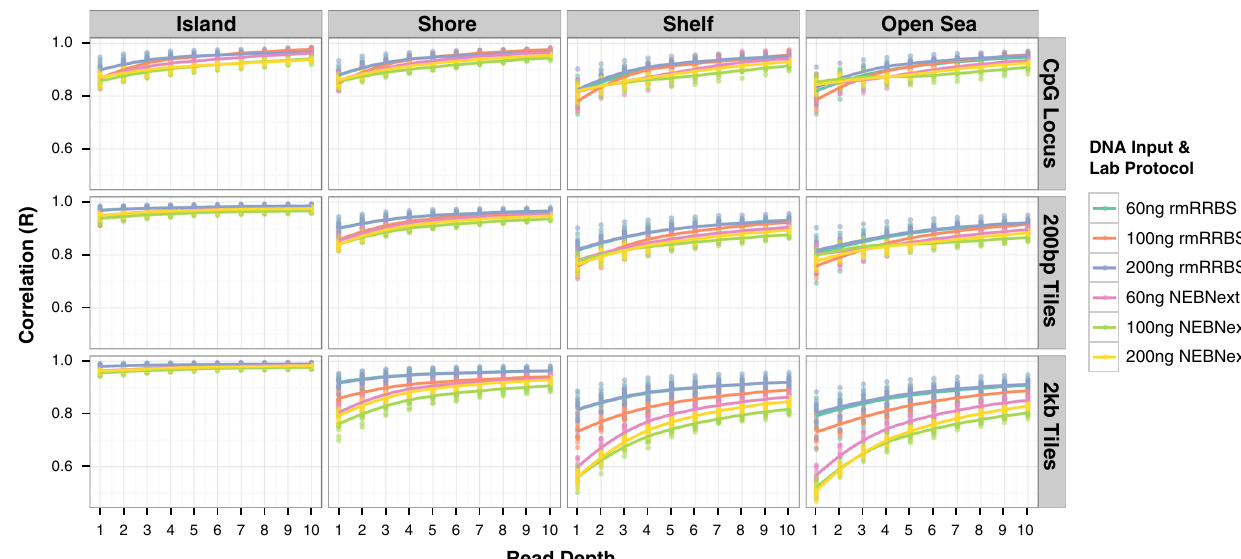
Fig. 4 Reproducibility of rmRRBS DNA methylation measurements. The Pearson correlations between DNA methylation measurements for combined reads from all 12 libraries prepared under each of six different experimental conditions and reads from the individual 12